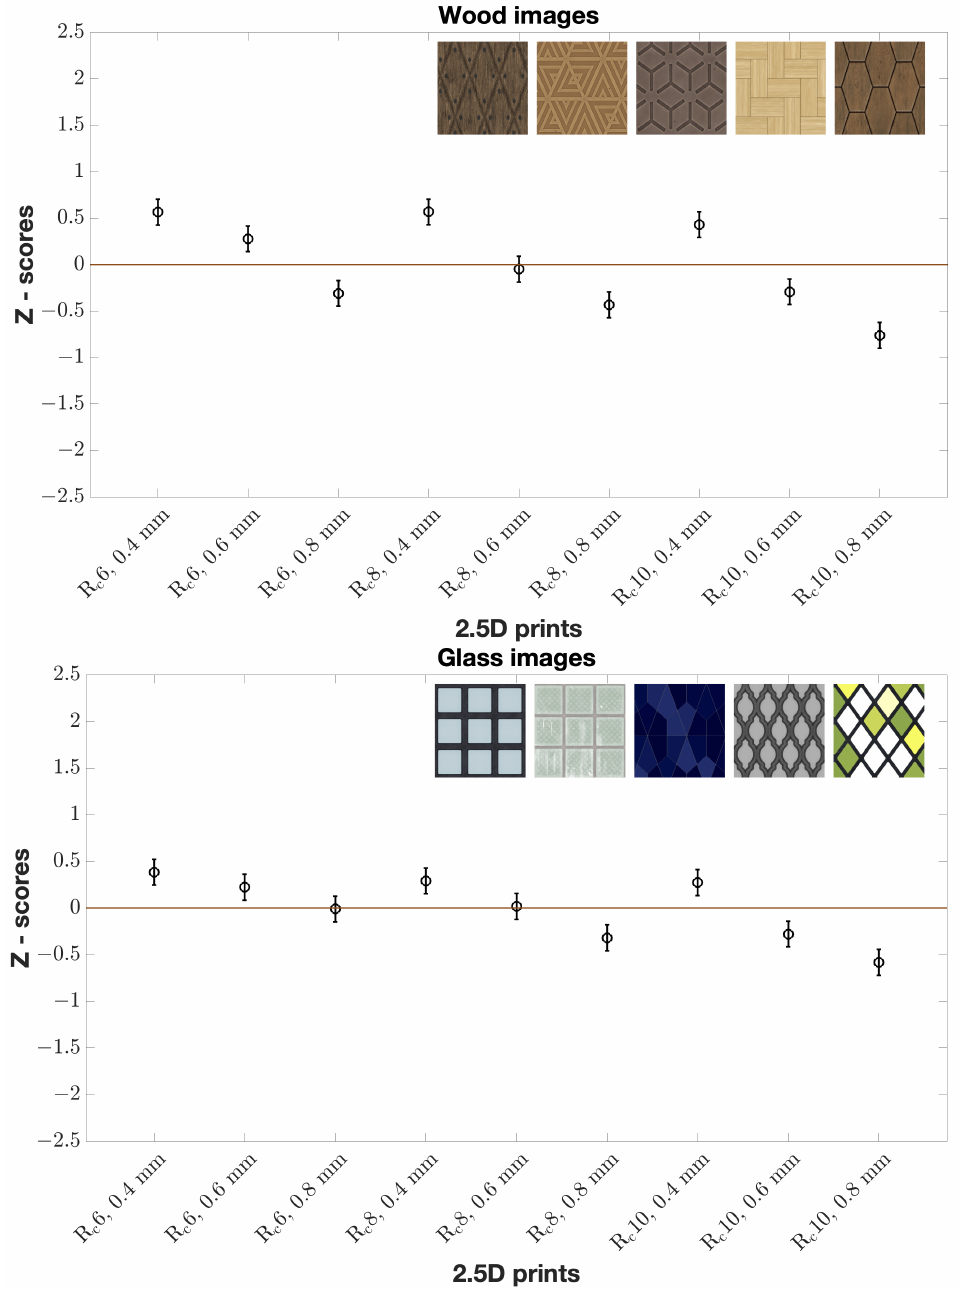
Figure 7. Z-scores of all images of wood and glass material categories by all observers. Mean Z-score values for nine reproductions (x-axis) are given with 95% CI s (represented by error bars). Z-scores have a small range. Each material category has five